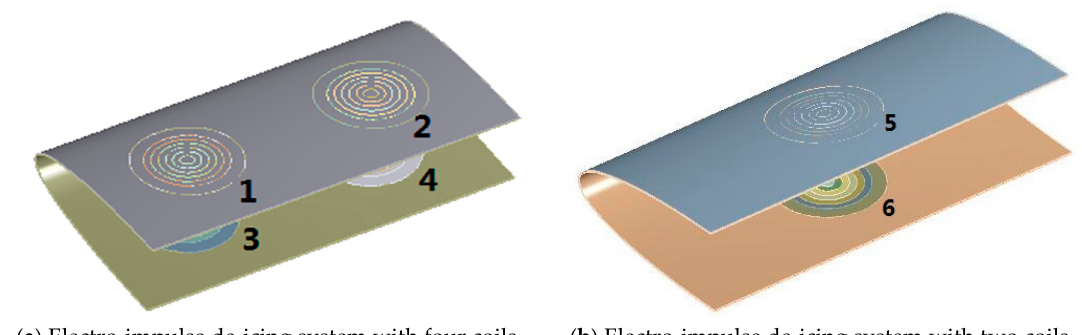
Figure 13. Position arrangement of multiple pulse coils.